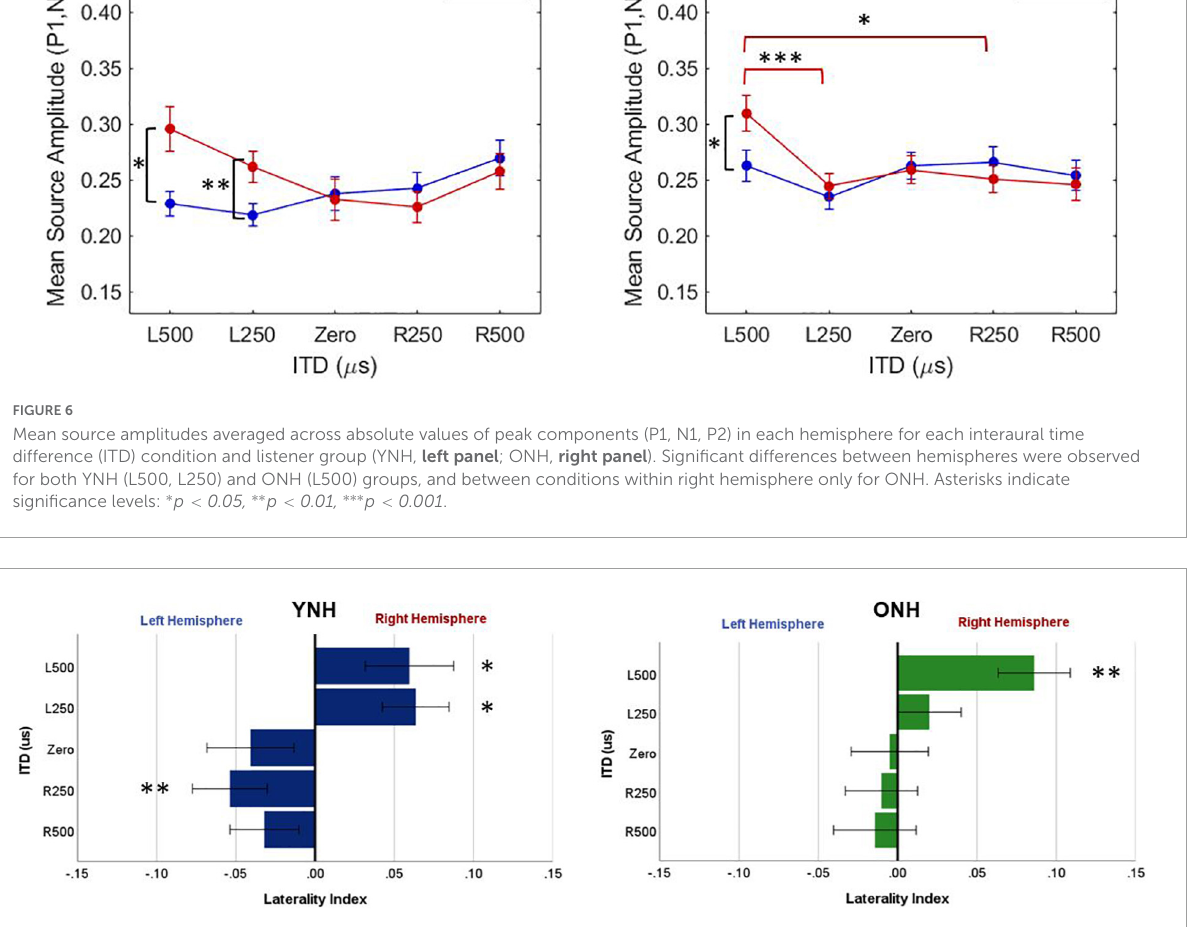
FIGURE7 Laterality index quantified from source-localized left and right hemisphere regions of interest (ROIs) for each interaural time difference (ITD) condition averaged across each group (YNH, left panel ; ONH, right panel ). Significant laterality (relative to zero) for given ITD conditions is indicated for the following p -values: ∗ p < 0.05 , ∗∗ p < 0.01